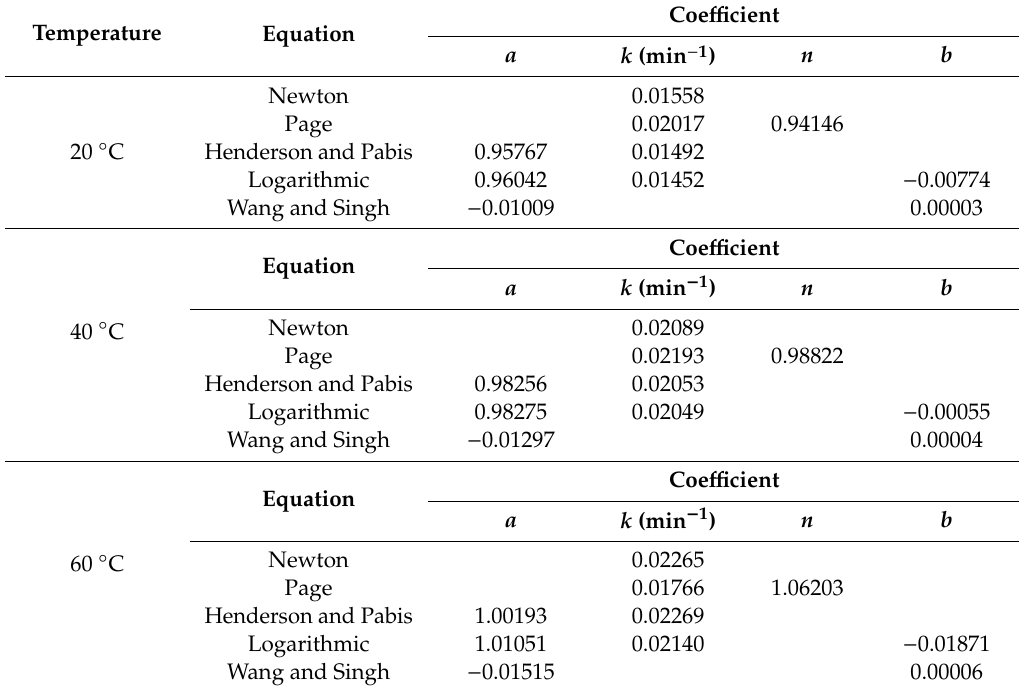
Table 6. Values in the models describing the vacuum drying of Moldavian